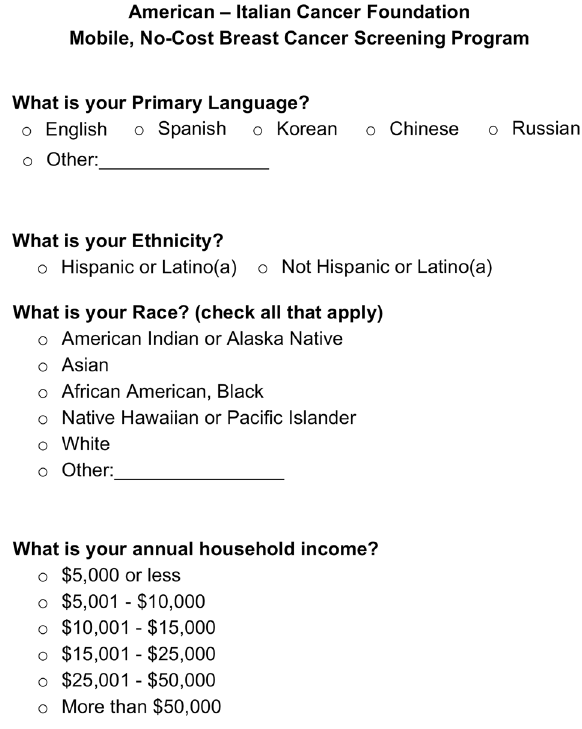
Fig. 3 Example of the Participant Questionnaire.